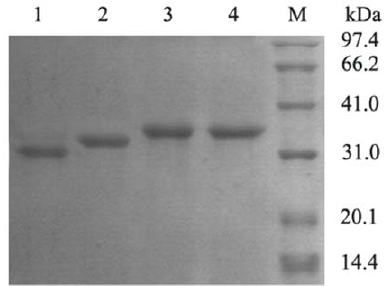
Figure 2. SDS-PAGE analysis of RCLCYS and RCL under reducing and nonreducing conditions. Lane 1 nonreduced RCLCYS, Line 2 nonreduced RCL, Line 3 reduced RCLCYS, Line 4 reduced RCL.